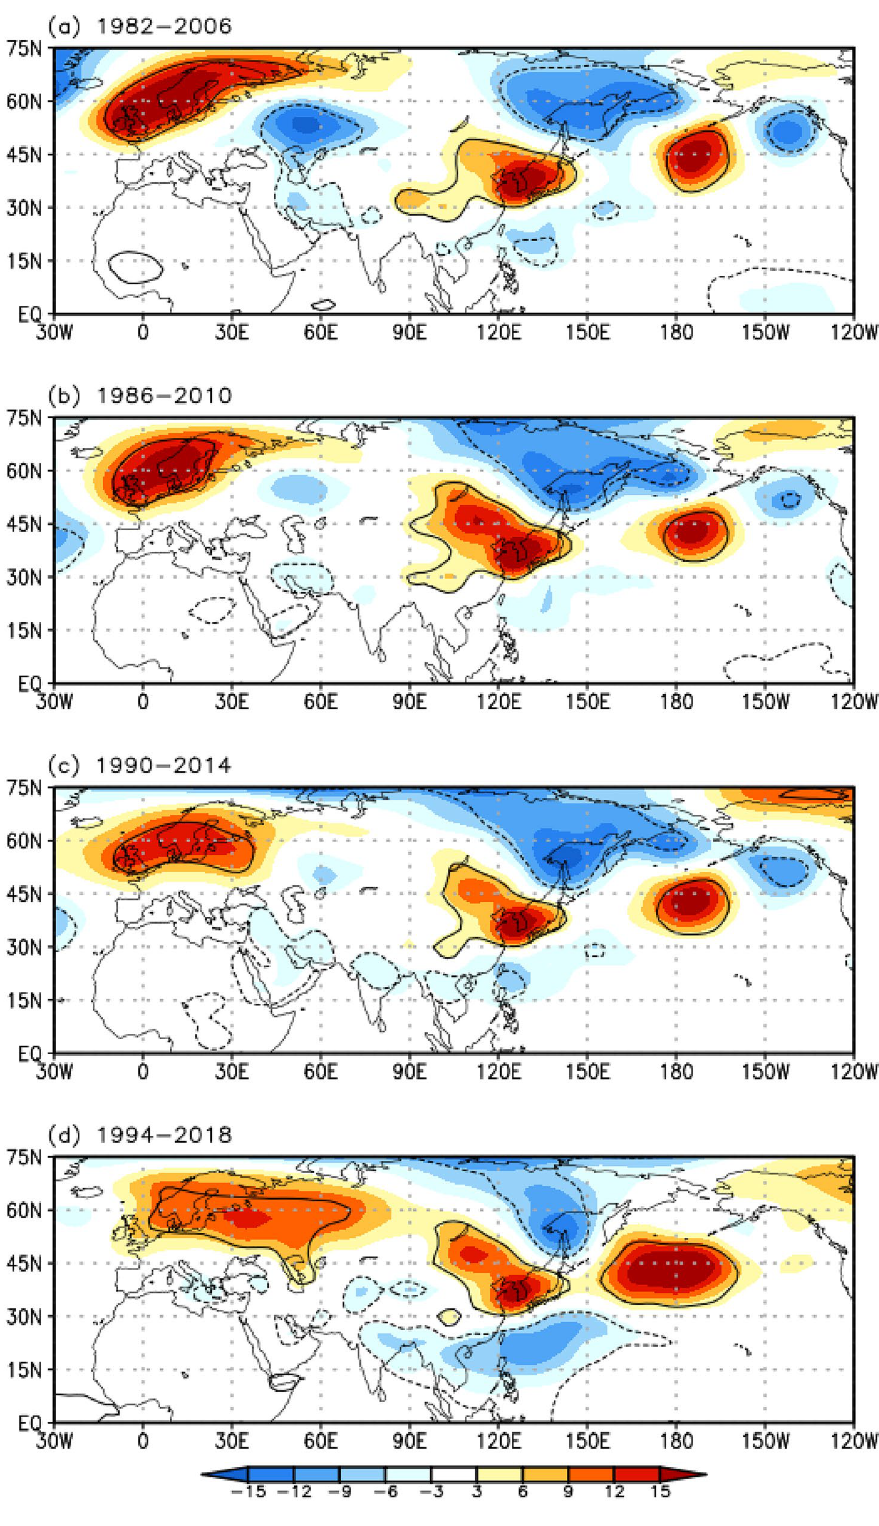
Figure 1. Composite maps of ( a ) the 850-hPa GPH (shaded; m) anomalies for the selected EHDs in South Korea from 1982–2006. ( b ), ( c ), and ( d ) are the same as ( a ) but for 1986–2010, 1990–2014, and 1994–2018, respectively. Contours represent statistically significant areas satisfying the 99% confidence level based on the Student’s t test. Maps were generated using GrADS version 2.1.a1 (http:// cola. gmu. edu/ grads/ downl oads.